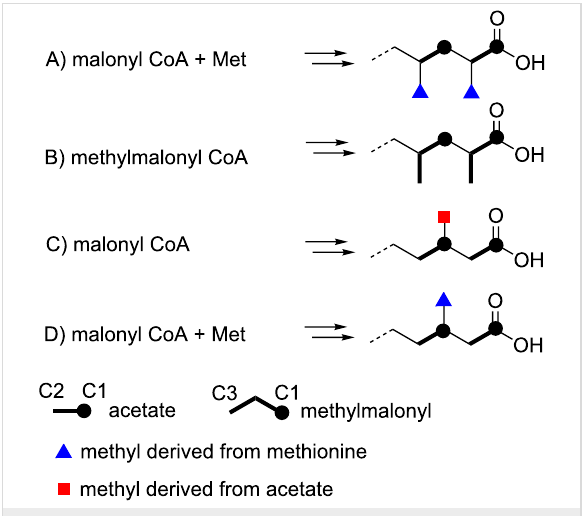
Figure 3: Methylation pattern that can occur in fatty acids and polyke- tides.